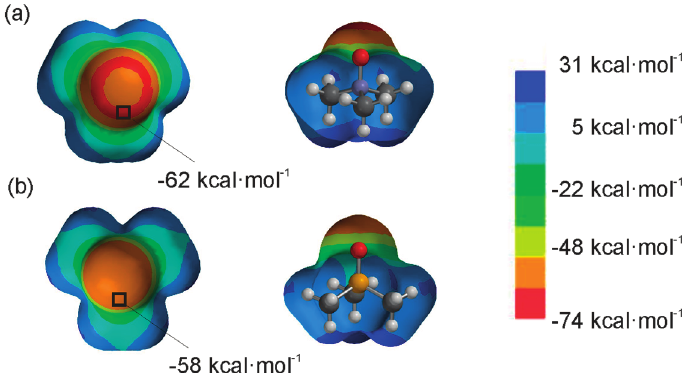
Figure 2. Top and side views of the representation of the electrostatic potential on the van der Waals surface for trimethylamine oxide 2a ( a ) and trimethylphosphine oxide 2b ( b ). The surface was calculated by using B3LYP/6-31G* in vacuum [24]. The location and the value for the minimum ESP are specified in each